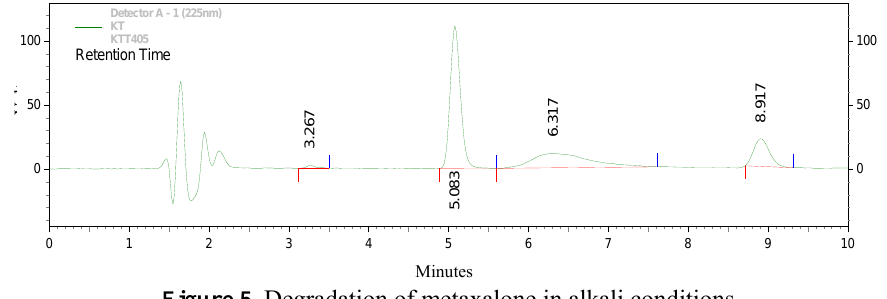
Figure 5. Degradation of metaxalone in alkali